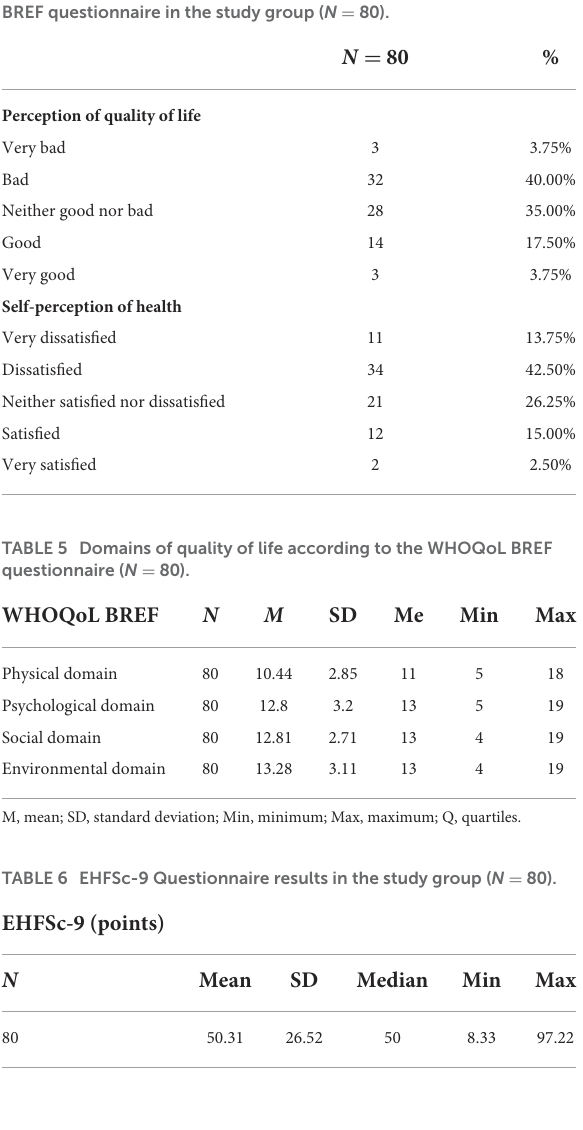
TABLE 7 The relationship between quality of life and self-care in the study group ( N =